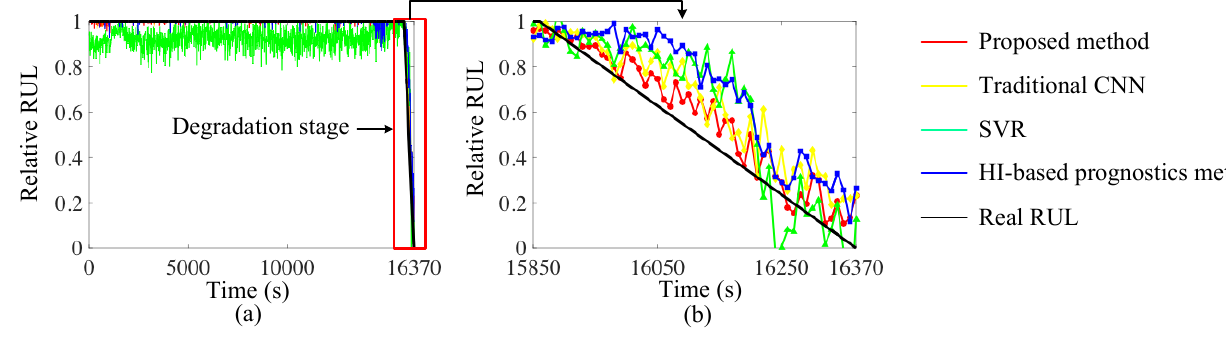
Figure 10. ( a ) RUL prediction results of the proposed method, traditional CNN method, SVR and HI-based prognostics method and ( b ) their